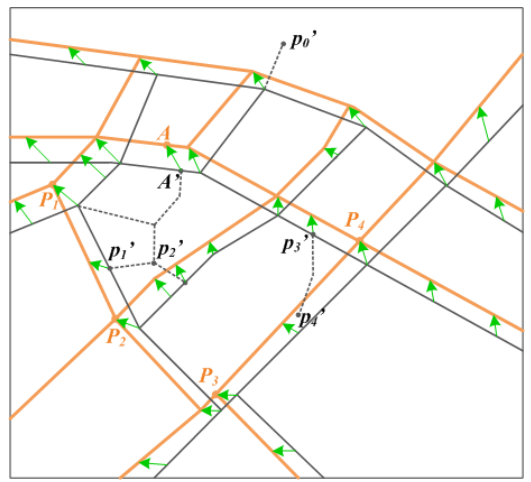
Figure 3. Matching between NAVTEQ and ATKIS. Orange lines: NAVTEQ; grey lines: ATKIS; dashed lines: pedestrian ways to be conflated (PWs-tbc); green arrows: linkages.